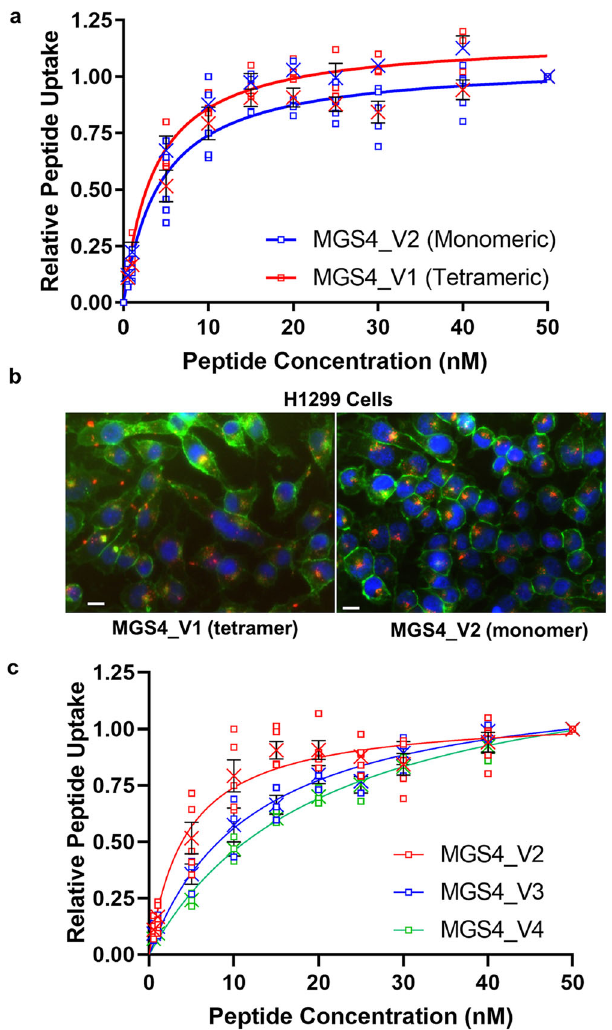
Fig. 1 Monomeric and tetrameric MGS4 have similar binding, internalization and subcellular location. a Binding and internalization of tetrameric MGS4_V1 and monomeric MGS4_V2 on live H1299 cells in culture. Cells were incubated with the peptide conjugated to streptavidin- phycoerythrin for 1 h at 37 °C. Non-internalized peptide was removed and the cells were analyzed by fl ow cytometry. b H1299 cells were incubated with MGS4_V1 or MGS4_V2 conjugated to streptavidin-Alexa Fluor 555 (red) for 1 h, washed, fi xed and counterstained with WGA-Alexa Fluor 488 (green, cell membrane) and DAPI (blue, nuclei) and analyzed by fl uorescence microscopy. The scale bar represents 20 µ m. MGS4_V1 and MGS4_V2 internalize to a similar degree and localize to a similar destination. c Truncated monomeric MGS4 peptides have similar EC50 as the parental full-length peptide. Individual measurements are shown. The mean is shown as an “ X ” and black error bars represent standard error for a minimum of three experimental replicates (SEM). All original binding data and nonlinear regression analysis of the data are included in the supplementary